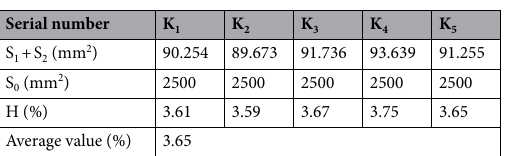
Table 1. Void ratio measurement result. K 1 –K 5 are the numbers of five void ratio test